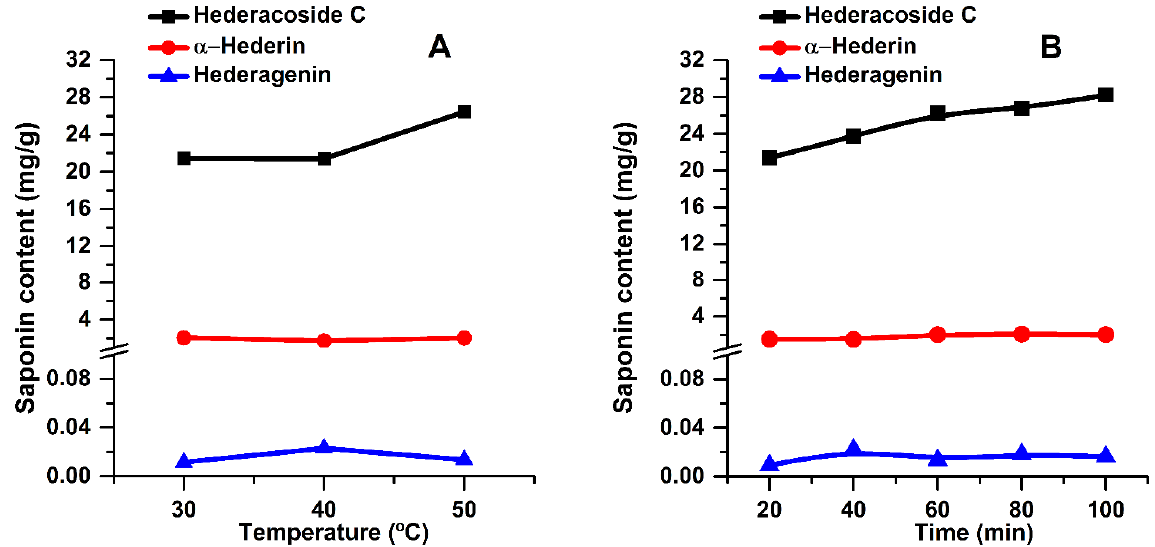
Figure 3. Influence of temperature ( A ) and extraction time ( B ) on the main saponins of the extracts (extraction conditions: a plant material to solvent ratio of 1:20 (w:v), continuous sonication, an ethanol concentration of 96%).